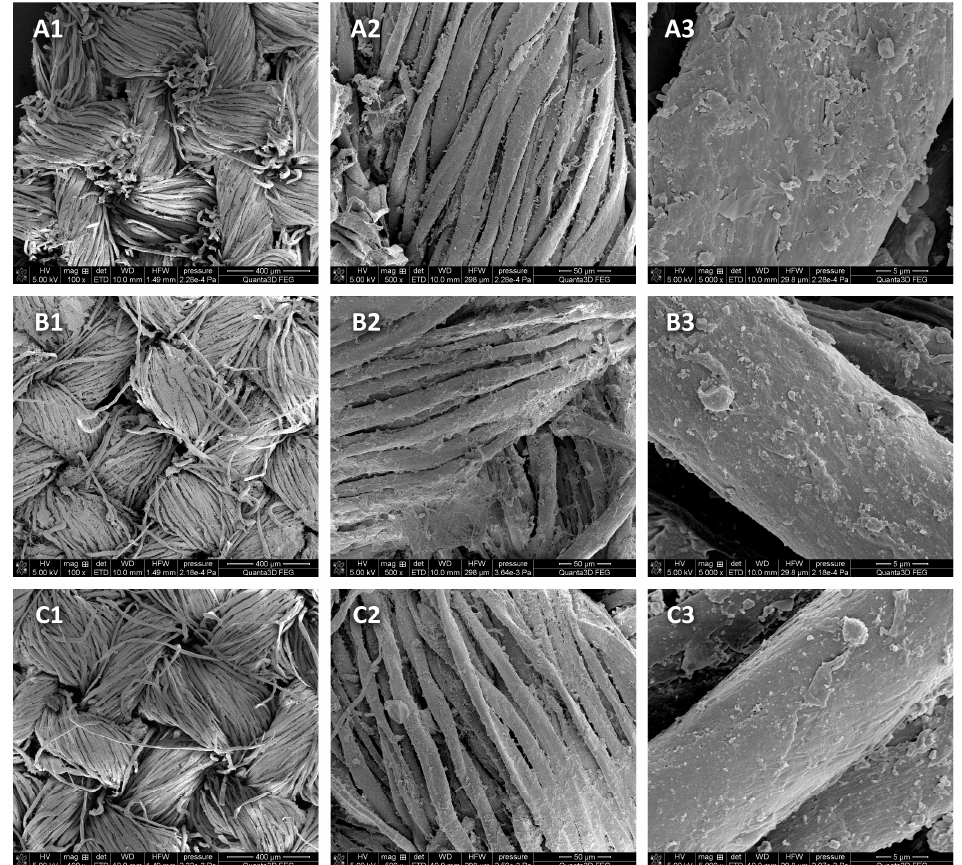
Figure 5. SEM micrographs showing the topographies and surface morphologies of the samples: ( A1 – A3 ) historical cotton—control; ( B1 – B3 ) historical cotton—after the application of 90% ethanol in the form of mist and direct drying; ( C1 – C3 ) historical cotton—after the application of 90% ethanol in the form of mist and drying after 22 h of storage in ethanol vapor. Enlargements: (1) 100×, (2) 500× and (3) 5000× .